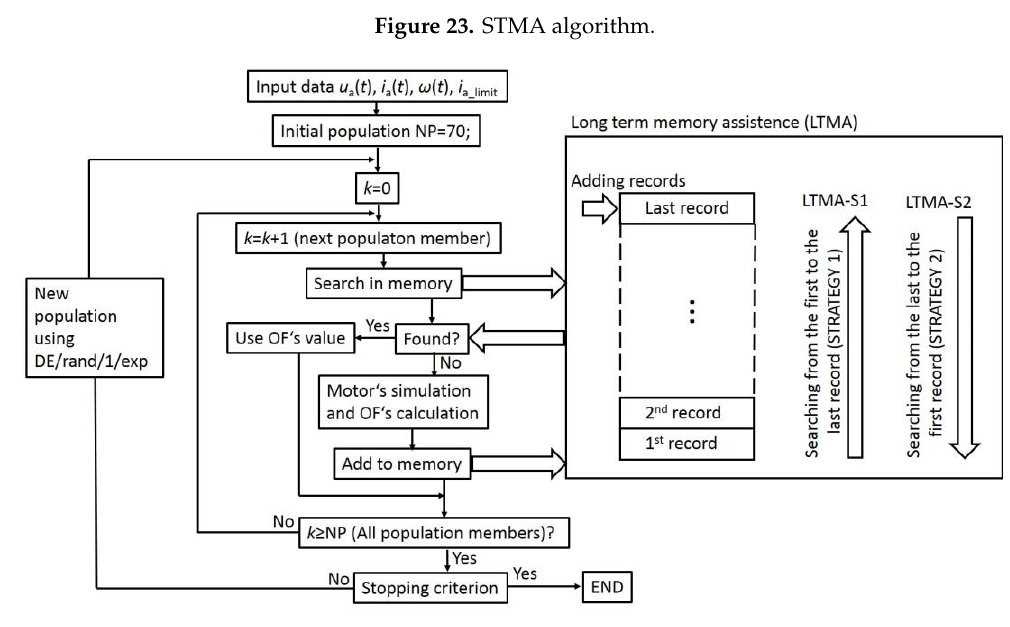
Figure 24. LTMA algorithm. Figure 24. LTMA